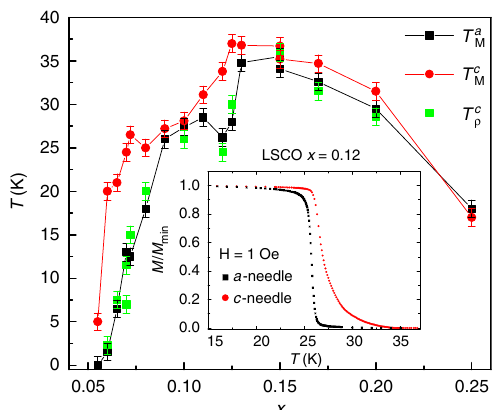
Fig. 1 LSCO phase diagram. Temperature versus Sr doping x for a - and c -needles. T M is the on-set temperature of diamagnetic signal taken from magnetization measurement and T ρ is the temperature where the resistivity goes to zero. Error bars represent the uncertainty in determining the transition temperature. The inset introduces an example of magnetization measurement for two x = 0.12 needles at H = 1 Oe NATURE COMMUNICATIONS| (2019) 10:2463